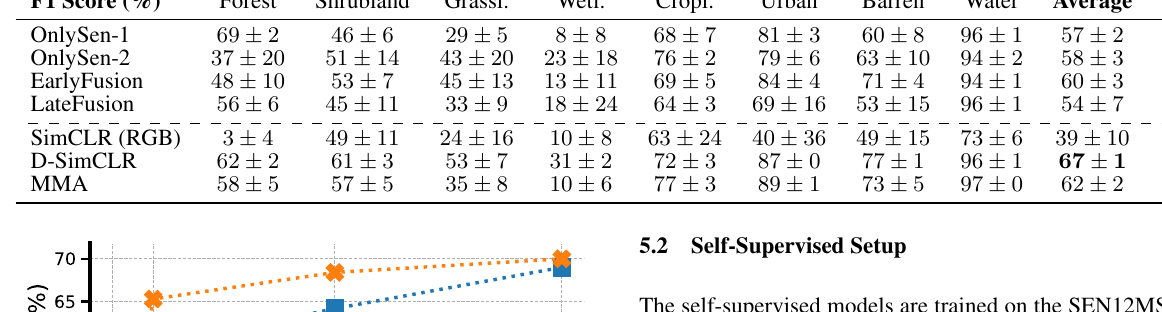
Table 2. F1-Score (%) for multi-label classification on the test set ( i.e. , DFC2020 validation split). Supervised methods OnlySen-1, OnlySen-2, EarlyFusion and LateFusion are trained from scratch, SSL methods SimCLR, D-SimCLR and MMA are fine-tuned on labelled data. O-F1 indicates overall F1-Score. Dashed line separates supervised and self-supervised methods. See notes for Table 1. F1 Score (%) Forest Shrubland Grassl. Wetl. Cropl.